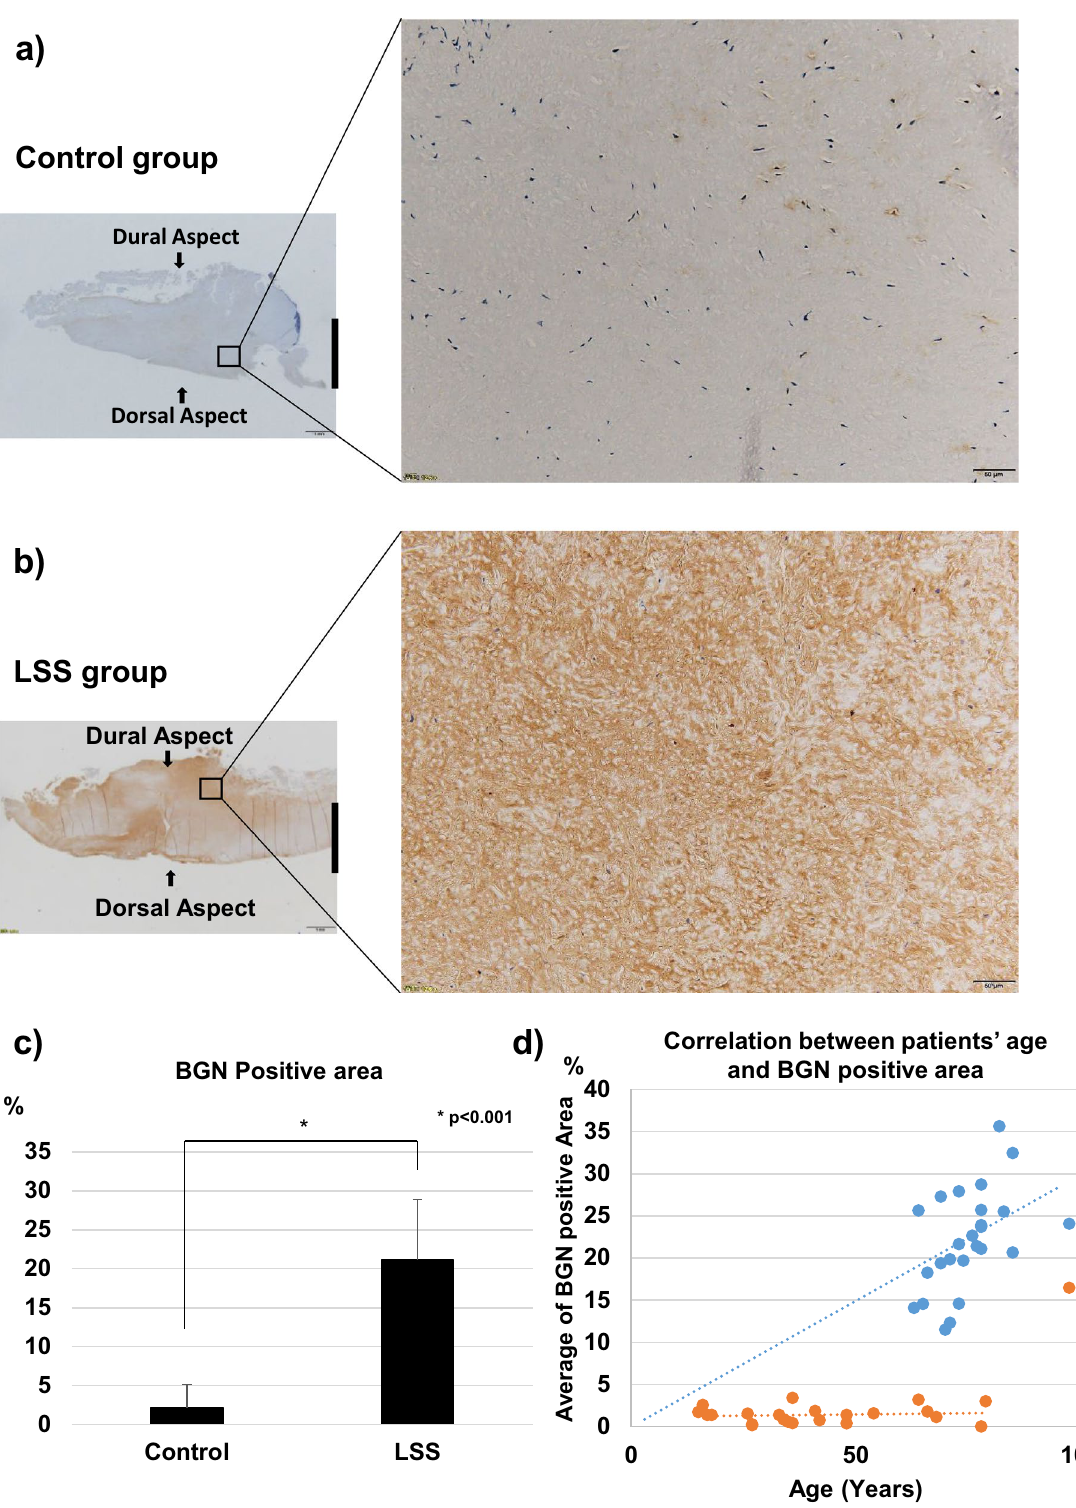
Figure 3. Immunohistochemistry for BGN in ( a ) non-hypertrophied (control) LF and ( b ) hypertrophied LF. Left, low magnification (scale bar represents 1 mm). The dorsal and dural sides (arrows) and the midline (black line) are indicated. Right, high magnification of boxed area in left image. Scale bar represents 50 µm. ( c ) The percentage of BGN-positive area in each group. ( d ) The relationship between patients’ age and the percentage of BGN-positive area in LSS group (blue) and control group